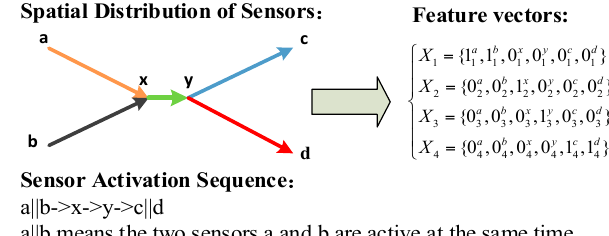
Figure 3. The uncertainty of the sensor response.